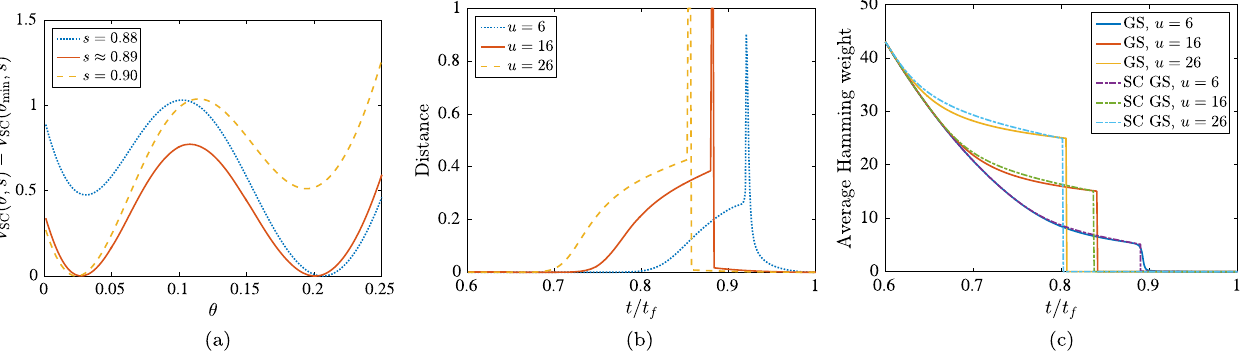
FIG. 2. Results for the fixed plateau problem with l ¼ 0 and n ¼ 512 . (a) The semiclassical potential with u ¼ 6 exhibits a double- well degeneracy at the position s ≈ 0 . 89 (solid line), but is nondegenerate before and after this point (dotted and dashed lines), thus leading to a discontinuity in the position of its global minimum. The same is observed for the other PHWO problems we study (not shown). (b) The trace-norm distance between the quantum ground state j ψ (obtained by numerical GS i corresponding to the instantaneous global minimum in V , as a function of t=t . diagonalization) and the spin-coherent state j ψ f SC GS i SC The peak corresponds to the location of the tunneling event, at which point the semiclassical approximation breaks down. (c) h HW i in the instantaneous quantum ground state (GS) and the instantaneous ground state as predicted by the semiclassical (SC GS) potential, as a function of t=t . The sharp drop in the GS and SC GS curves is due to a tunneling event wherein ∼ u qubits are flipped, which occurs at f the degeneracy point observed in the spin-coherent